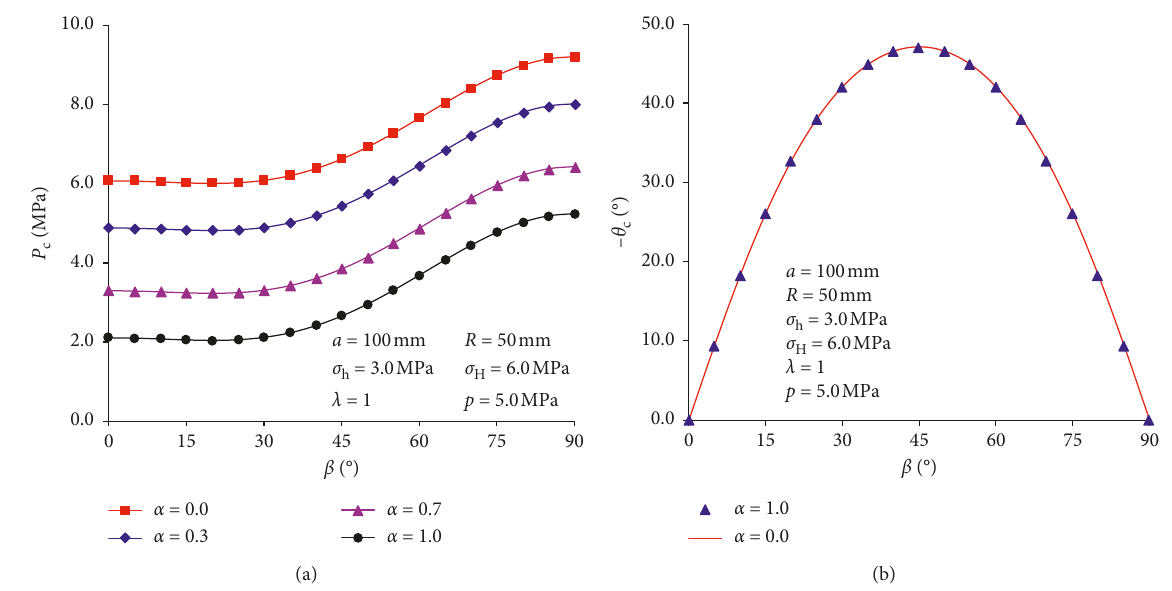
Figure 14: Effect of Biot’s coefficient on the critical water pressure and critical initiation angle.